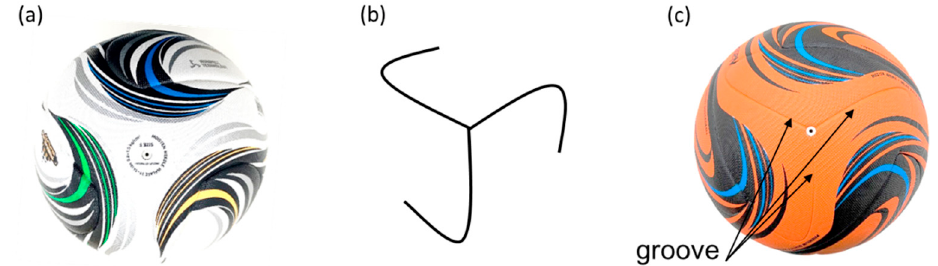
Figure 1. Wind-tunnel setup.